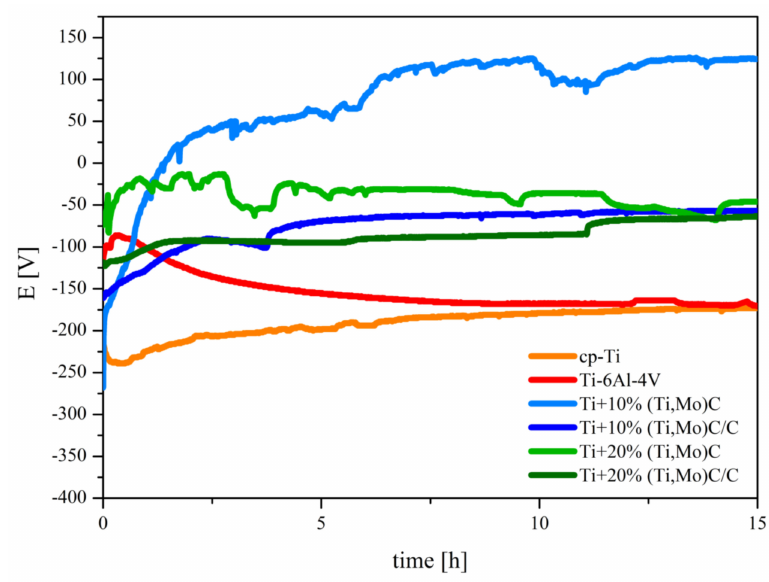
Figure 16. The curves of OCP variation versus time of the specimens exposition to the 3.5 wt % NaCl solution at temperature 22–23 ◦ C.